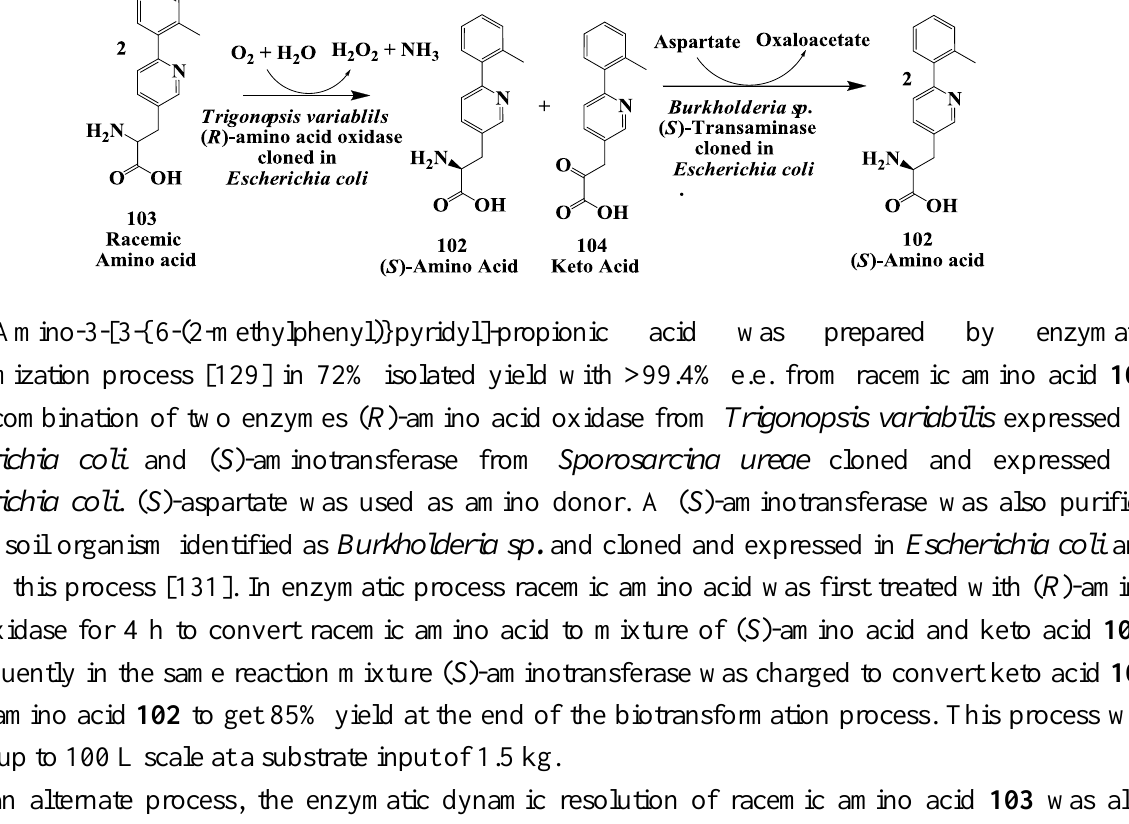
Figure 28. Glucogen like peptide: The ( S )-amino-3-[3-{6-(2-methylphenyl)}pyridyl]-propionic acid.